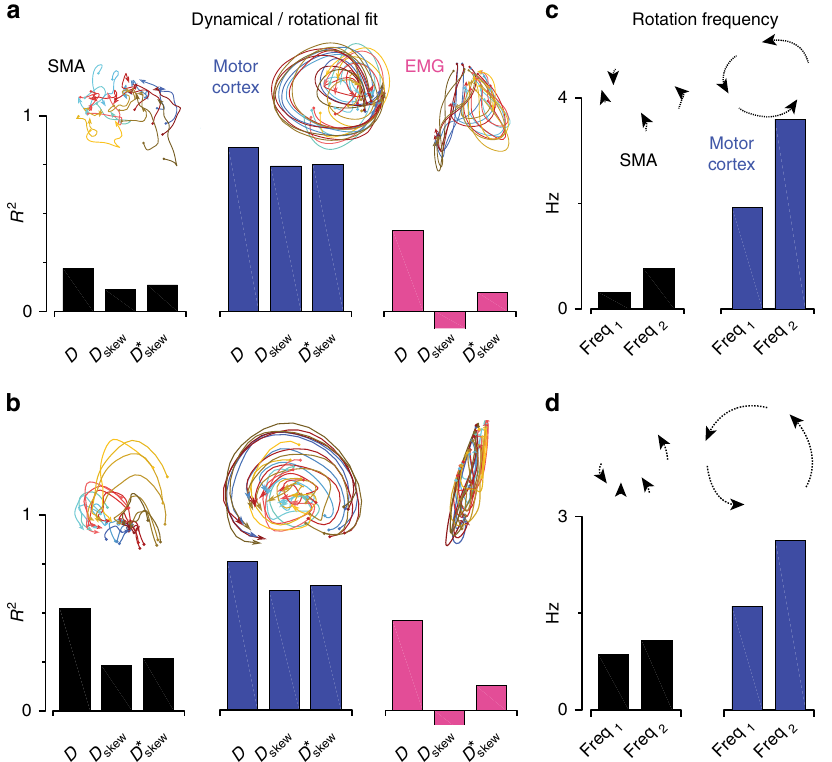
Fig. 6 Quanti fi cation of dynamical structure. Insets indicate the nature of the structure being quanti fi ed. a Fit quality provided by unconstrained ( D ) and constrained ( D skew and D (cid:3) ) linear dynamical fi ts. Fits are made over a 200 ms window, starting at movement onset, during which fi ring rates are skew changing rapidly. Results were robust to reasonable window sizes, so long as they included the time when responses were in rapid fl ux. For example, all p- values quoted in the text are lower (more signi fi cant) when using an earlier window: from 80 ms before movement onset until 150 ms after. Negative values, in the case of EMG, have been truncated. Data are for monkey Ba. b Same as a but for monkey Ax. c Rotational frequencies derived from D (cid:3) SMA and motor cortex. Data are for monkey Ba. d Same as c but for monkey